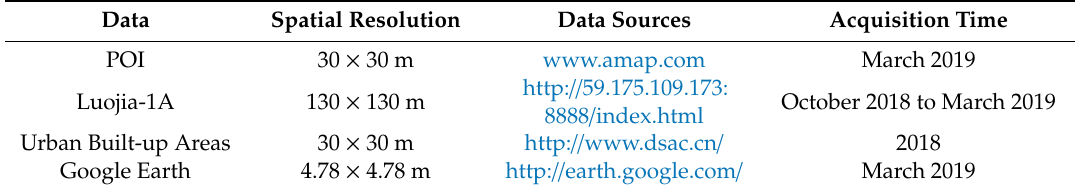
Figure 3. Proportions of POI data in different categories for built-up areas and sub built-up areas in Kunming in March 2019. Table 1. Data